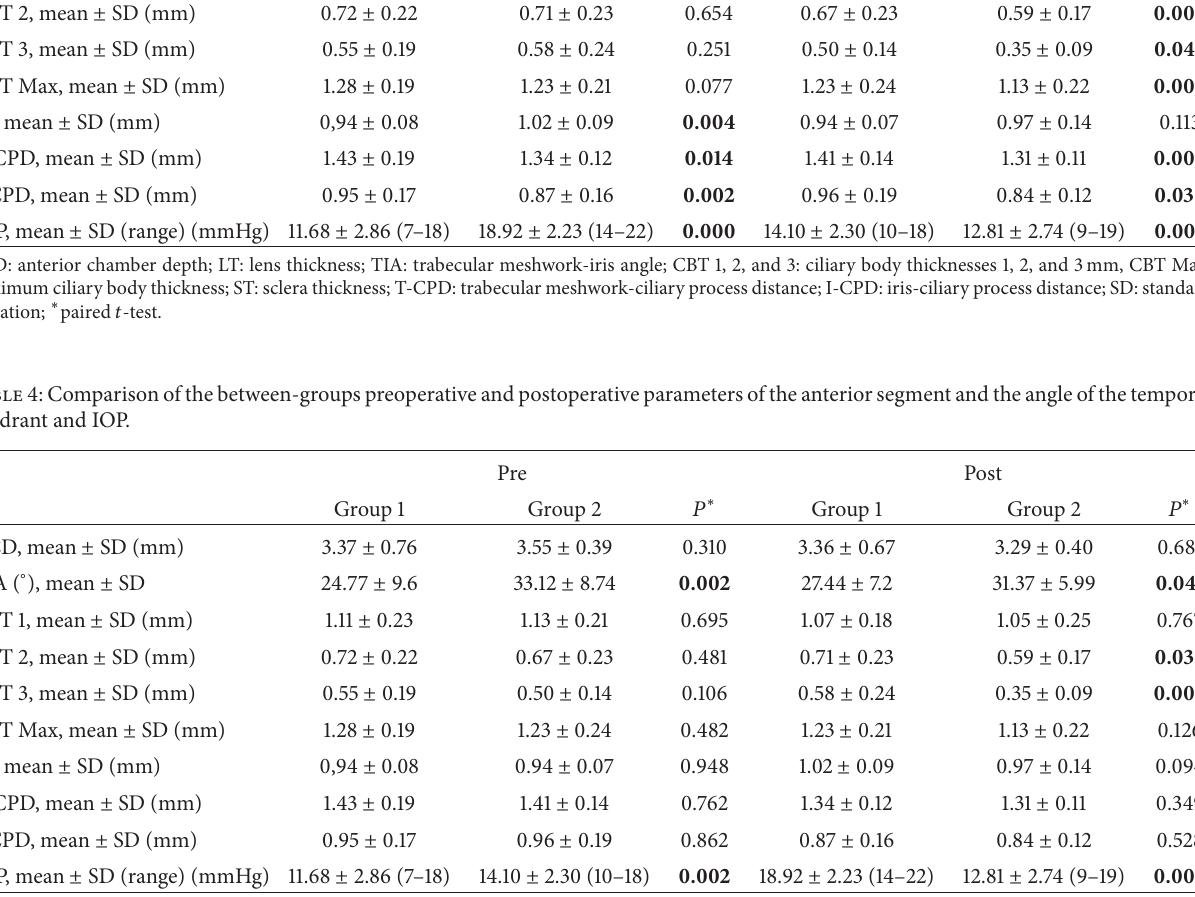
ACD: anterior chamber depth; LT: lens thickness; TIA: trabecular meshwork-iris angle; CBT 1, 2, and 3: ciliary body thicknesses 1, 2, and 3mm, CBT Max: maximum ciliary body thickness; ST: sclera thickness; T-CPD: trabecular meshwork-ciliary process distance; I-CPD: iris-ciliary process distance; SD: standard deviation; ∗ independent samples 𝑡